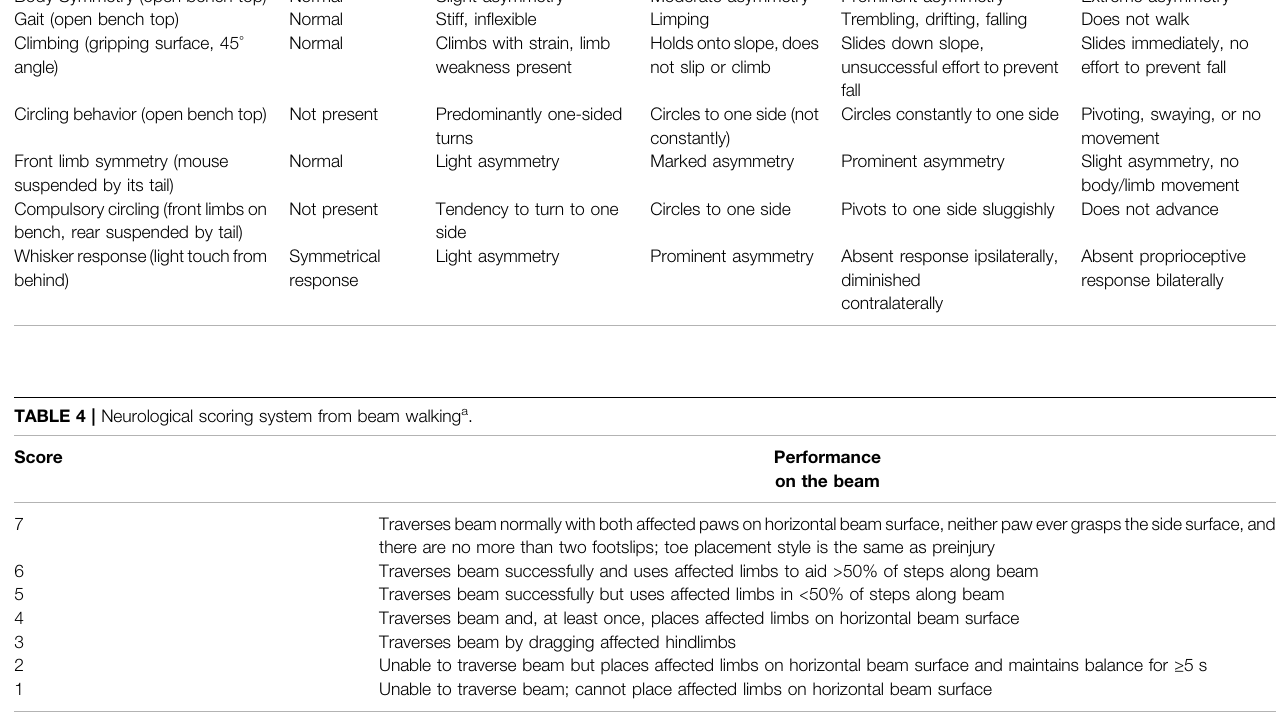
Front limb symmetry (mouse suspended by its tail)